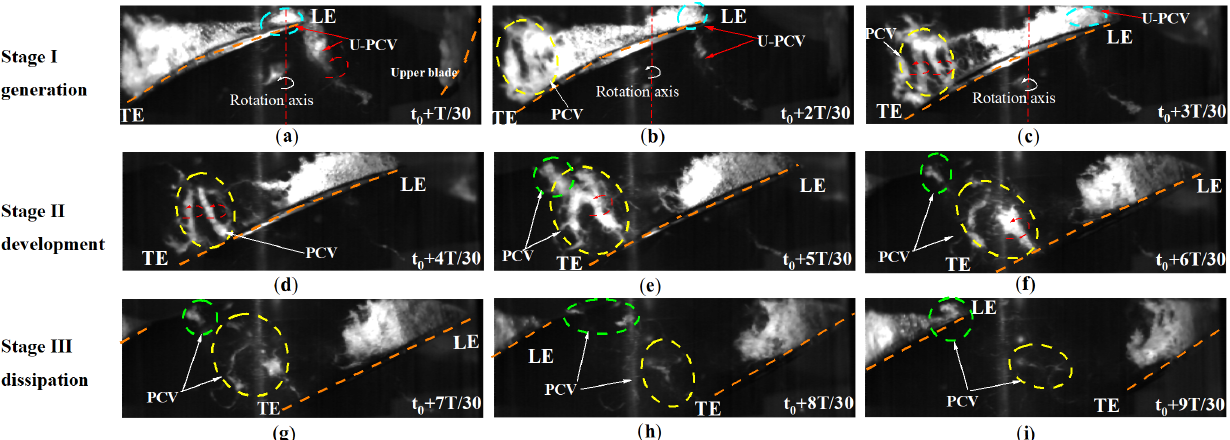
Figure 7. High-speed photography experimental diagram of axial flow pump impeller at different times ( Q = 0.8 Q BEP , σ = 0.35).